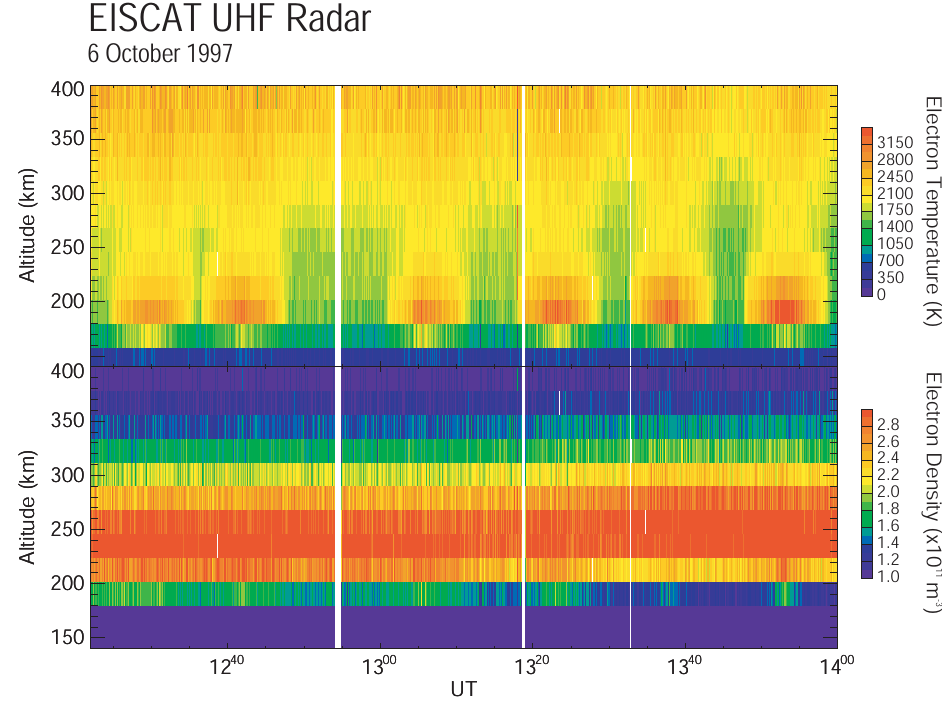
Fig. 6. Ionospheric electron temperature (upper panel) and electron density (lower panel) measured by the EISCAT UHF radar whilst pointing field aligned during the interval shown in Fig. 3.